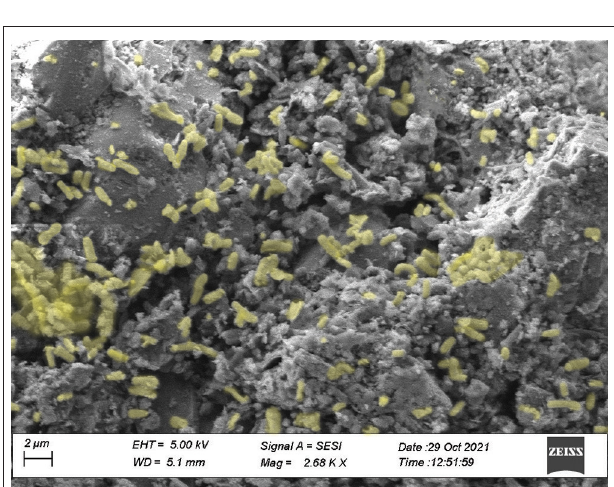
FIGURE 2 | The reported electron micrograph shows Salmonella Typhimurium, highlighted in yellow, adsorbed to the surface of PowerGuard. SEM images were taken by Zeiss crossbeam 540 at 5 kiloelectron volts (kV) using secondary electrospray ionization detector (Zeiss Meditec Inc., Dublin, CA, USA). Samples were observed at the Texas Tech University Microscopy Core Laboratory by SEM with the help of Dr.